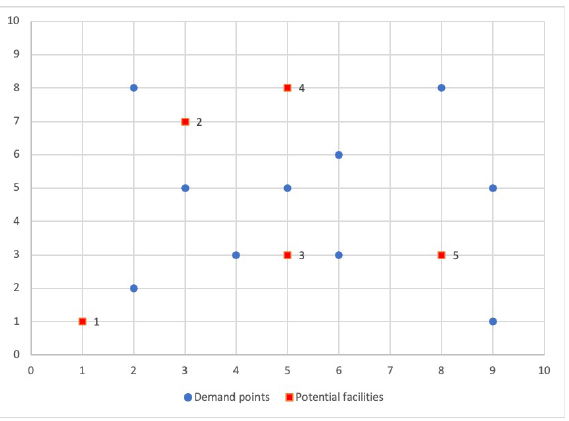
Figure 1. Small instance for the comparison of the objective functions ( k = 3).